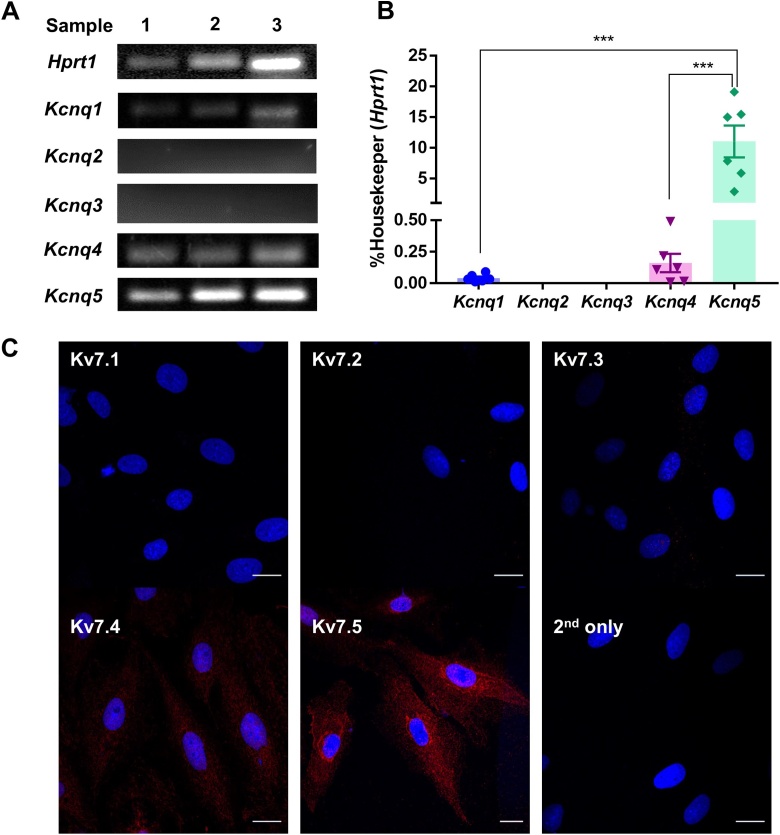
Expression of Kcnq genes and Kv7 proteins in A7r5 cells. (A) Agarose gels stained with SYBR safe to visualise the RT-PCR products of Kcnq1, Kcnq2, Kcnq3, Kcnq4 and Kcnq5. (B) Quantification of RT-PCR results exemplified in panel A, expression is normalised to that of a housekeeping gene, Hprt1 (hypoxanthine phosphoribosyltransferase 1). (C) Immunofluorescence labelling of Kv7.1 – Kv7.5 channel subunits in A7r5 cells, scale bars are 20 μm. In panel B data are presented as mean ± S.E.M.; ***P < 0.001 (n = 6).